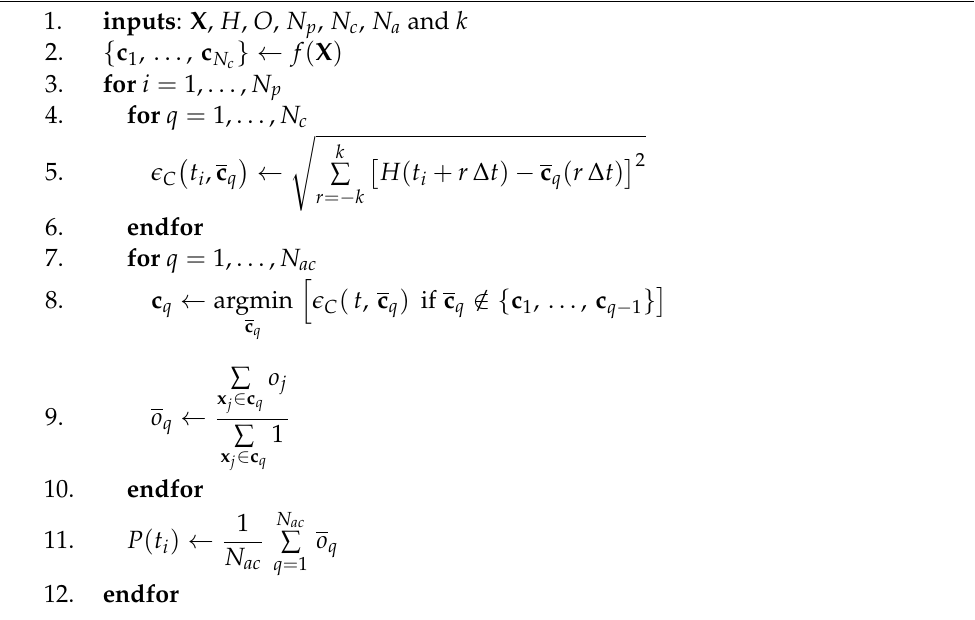
Algorithm 4: Cluster-based AnEn for dependent